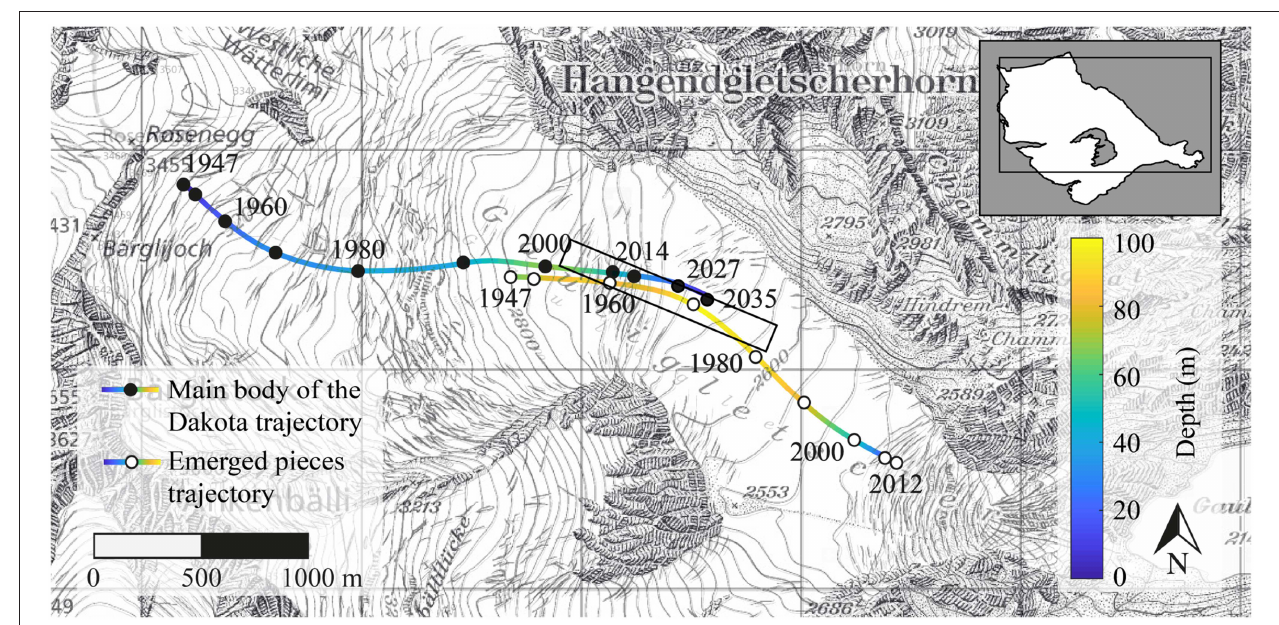
FIGURE 5 | Modeled horizontal trajectories of the main body of the Dakota (line with solid marker) and emerged pieces (line with open marker). The rectangle indicates the confidence area of the main body of the Dakota emergence location, taking into account the uncertainness listed in the text.